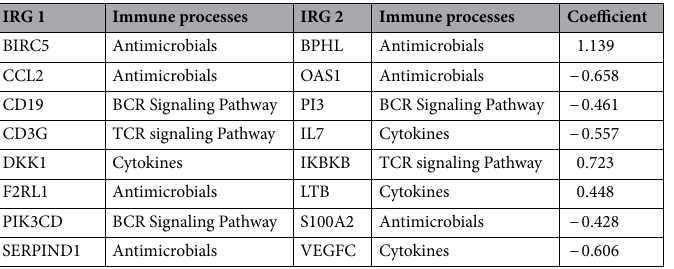
Table 2. Information on the 8 immune-related gene pairs (IRGPs). IRGPs immune-related gene pairs, IRG immune-related gene.